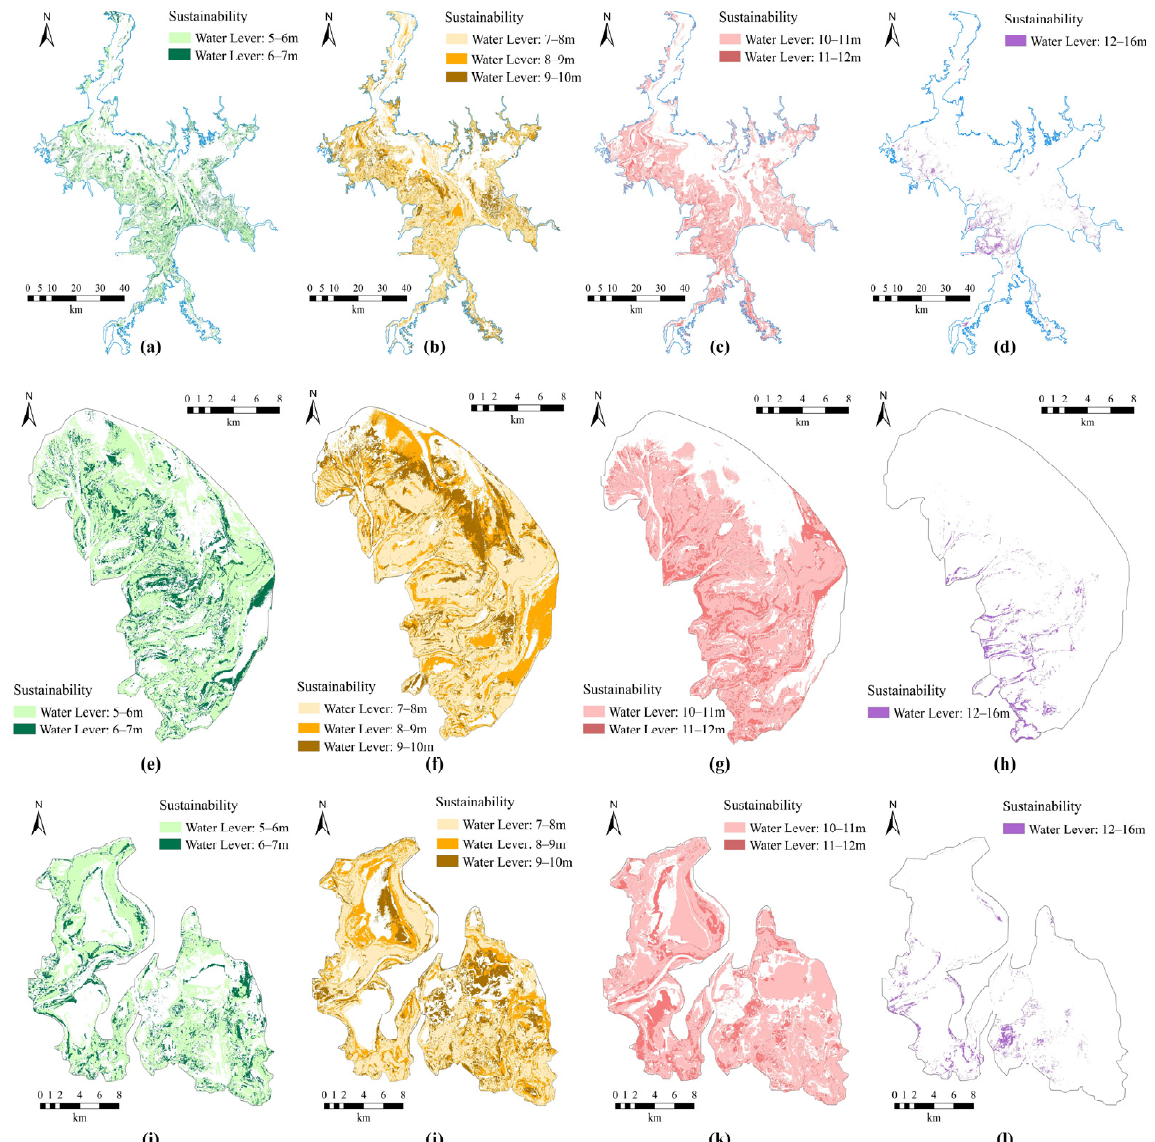
Figure 3. Distributions of the sustainable crane habitats in: ( a – d ) Poyang Lake wetland; ( e – h ) Nanji wetland reserve; and ( i – l ) Poyang Lake reserve.